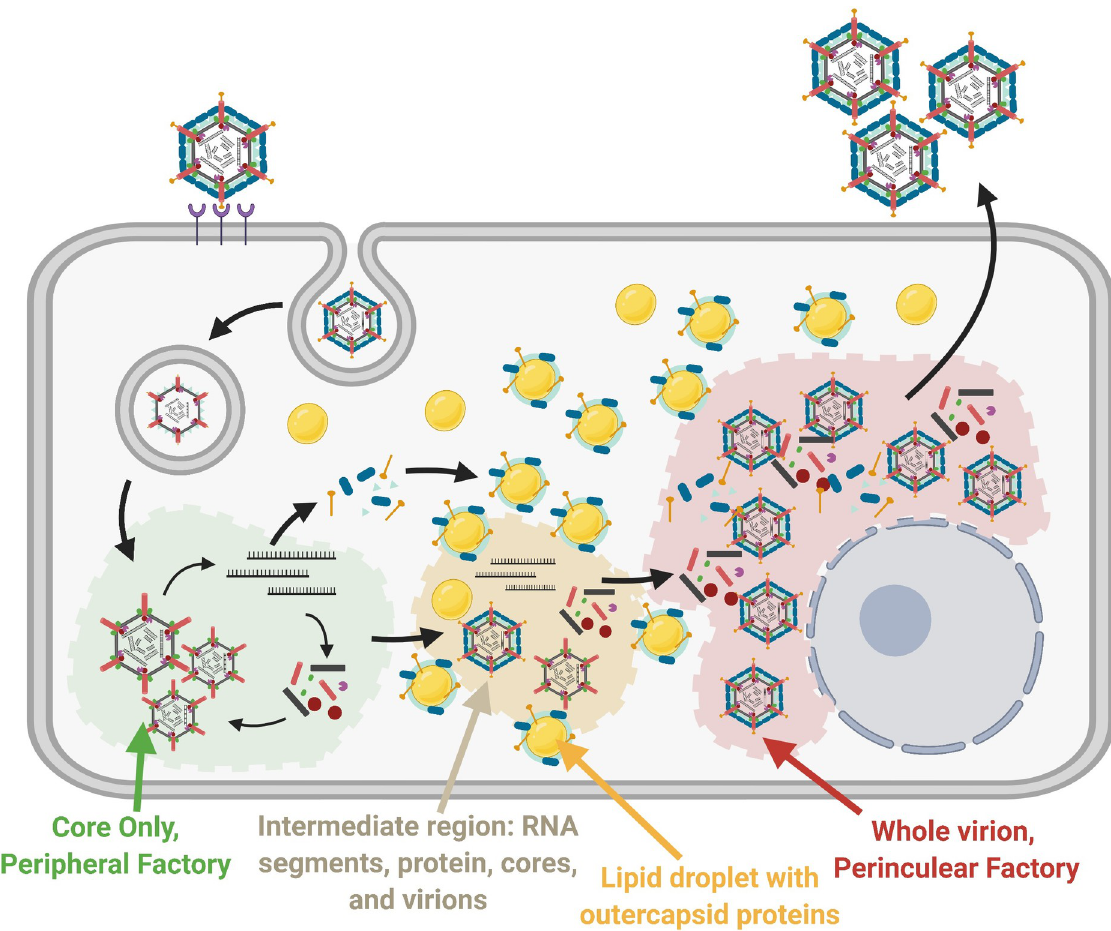
Fig 10. Reovirus assembly is spatially and temporally compartmentalized. A cartoon model summarizing the findings of our study. There exist four segregated areas of reovirus assembly: 1) Core-only peripheral factories, 2) Intermediate regions where residual amplified RNA is translated to proteins and assembled into particles, 3) OC proteins on LDs, and 4) whole virions and core and OC proteins in perinuclear factories. After entry, core particles undergo primary transcription and translation in peripheral core-only factories. Newly synthesized proteins assemble into progeny cores, which then undergo secondary rounds of transcription and translation. As infection progresses, μ 1 facilitates OC protein accumulation on LDs, and perinuclear factories form containing predominantly assembled whole virions. Figure created using